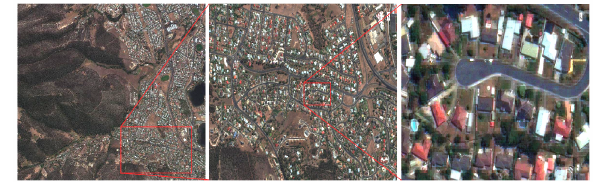
Figure 6. Global, regional and local image area (Fries 2017)